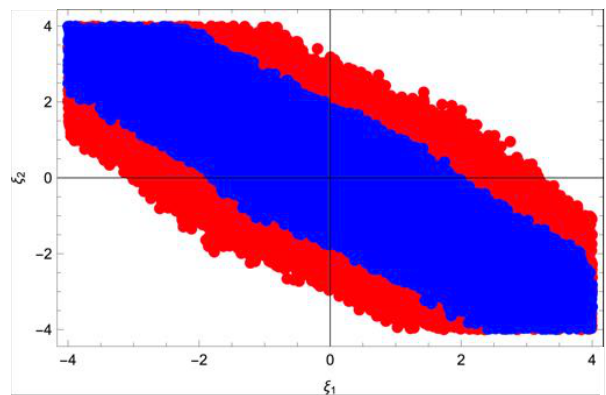
Figure 7 . The parameter space of (cid:24) 1 and (cid:24) 2 allowed by the chi-square goodness of (cid:12)t. The blue and red points correspond to (cid:3) = 3 TeV and (cid:3) = 5 TeV respectively. parameter space allowed by the chi-square test is shown in (cid:12)gure 7. The region shrinks by reducing the value of (cid:3). Since the relationship between the K (cid:24) ; (cid:24) parameters depends on (cid:11) and (cid:12) , the S; T constraints in the last subsection will 1 2